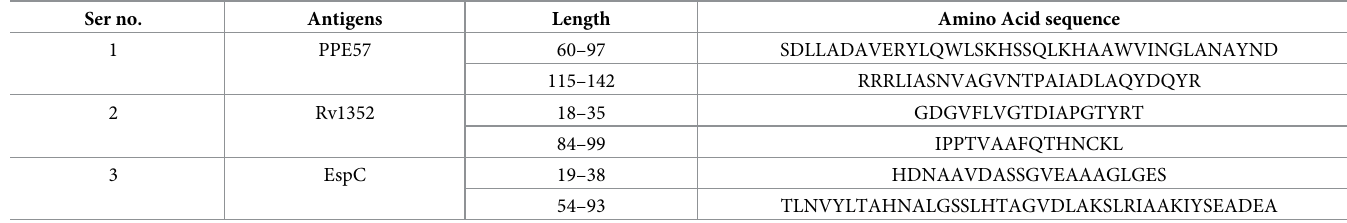
Table 2. Th1-cell epitopes predicted for the Mtb antigens.